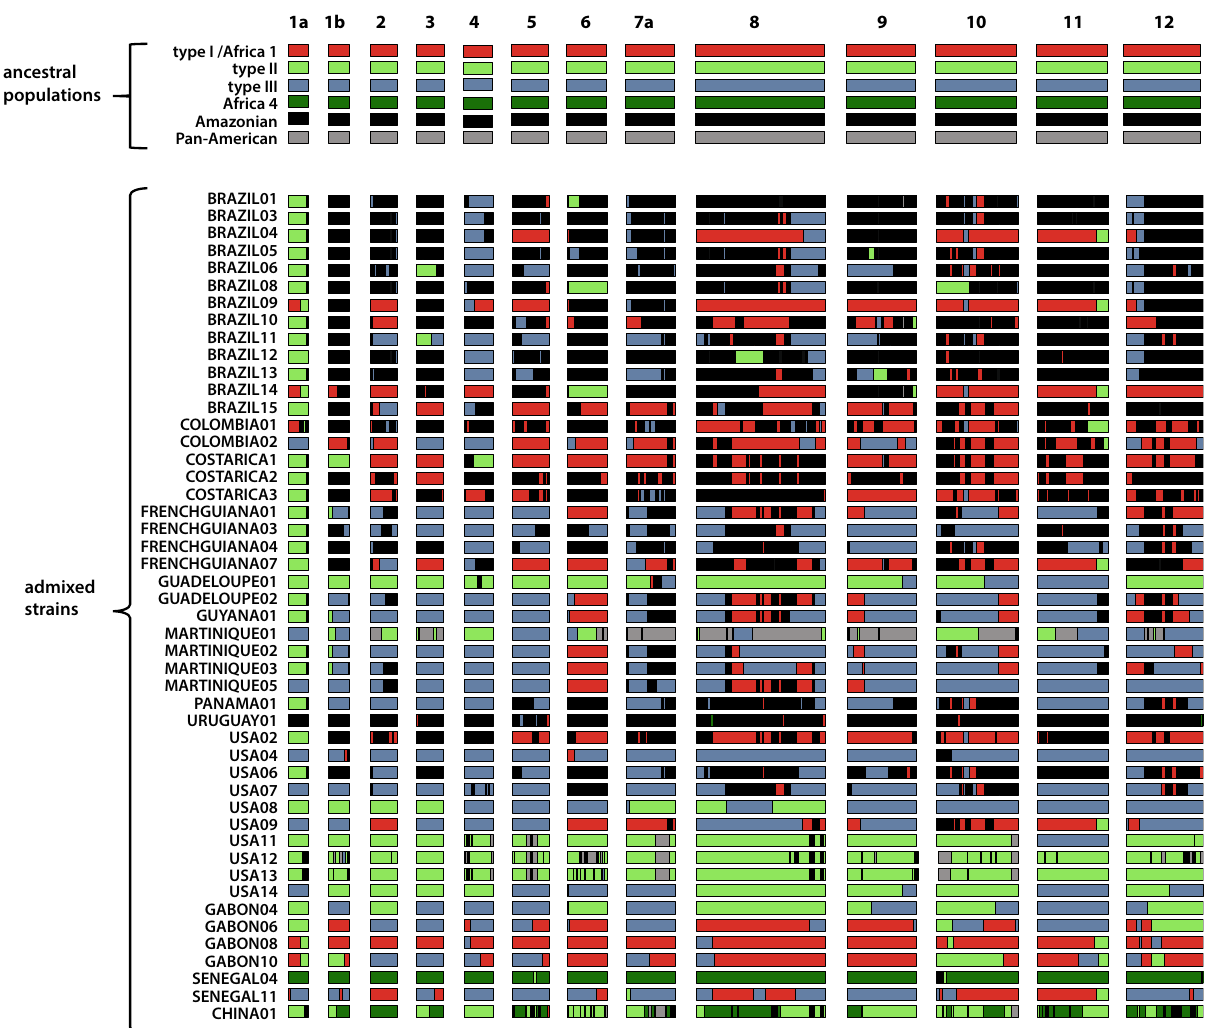
Fig. 3 | Genome-wide distribution of ancestry in all putative hybrid Toxoplasma gondii genomes. Plots are graphically displayed using karyoploteR 68 and show ancestry estimates at each genomic position for the 13 nuclear chromosomes (1a – 12). Colours in plots re fl ect putative ancestral